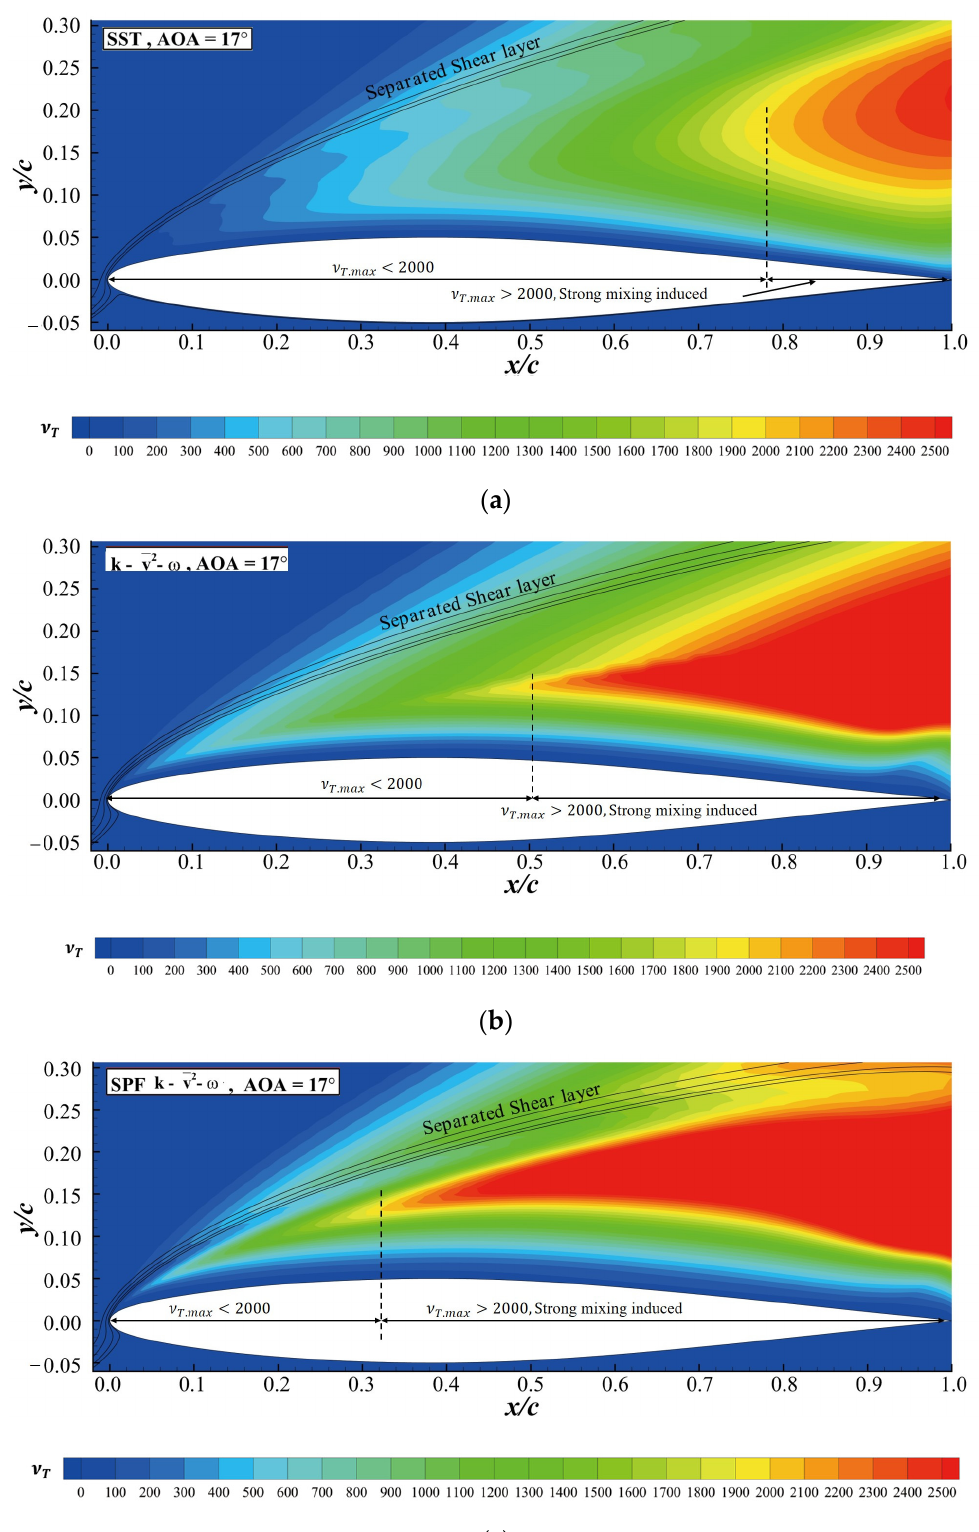
Figure 7. 𝜈 (cid:3021) contour at 𝐴𝑂𝐴 = 17°, 𝑅𝑒 = 3 × 10 (cid:2873) and 𝑀𝑎 = 0.12 . The separated shear layer and Figure 7. ν T contour at AOA = 17 ◦ , Re = 3 × 10 5 and Ma = 0.12. The separated shear layer and the the region where 𝜈 (cid:3021) > 2000 are marked in the figure. (a) SST model. (b) 𝑘 − 𝑣 (cid:2870) (cid:3364)(cid:3364)(cid:3364) − 𝜔 model. (c) SPF region where ν T > 2000 are marked in the figure. ( a ) SST model. ( b ) k − v 2 − ω model. ( c ) SPF model.